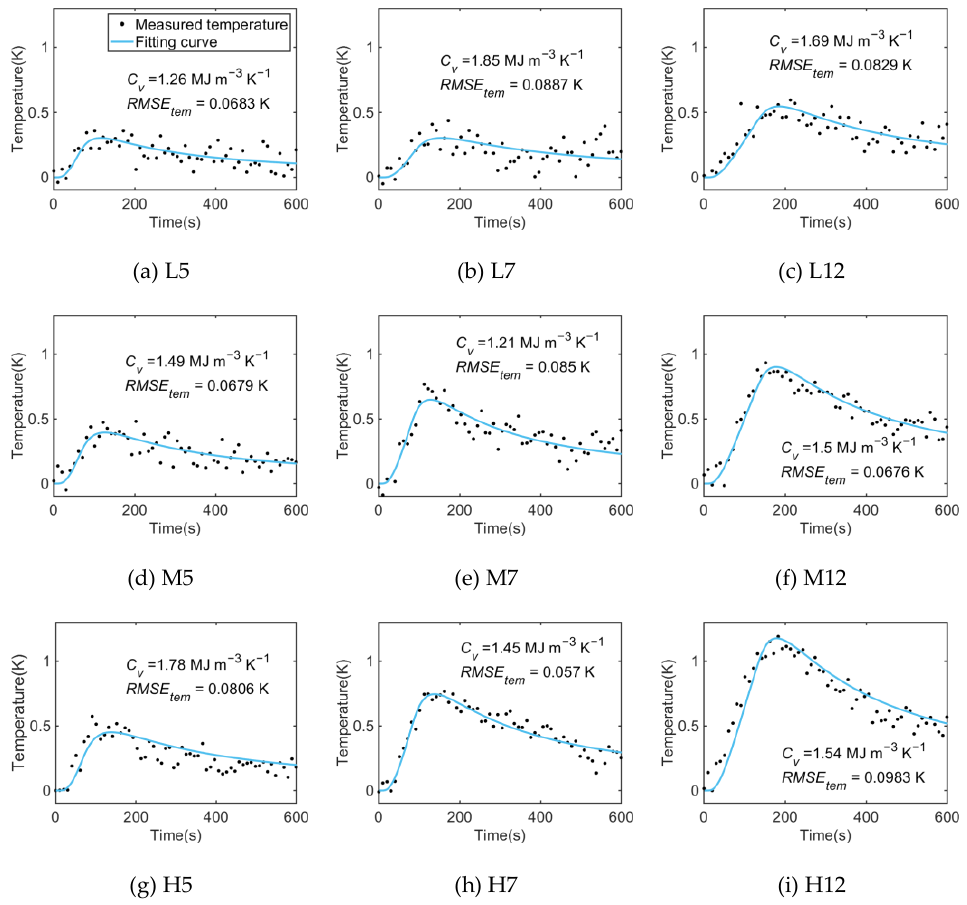
Figure 4. Fitting curves of the sand heat pulse process under different heating strategies.